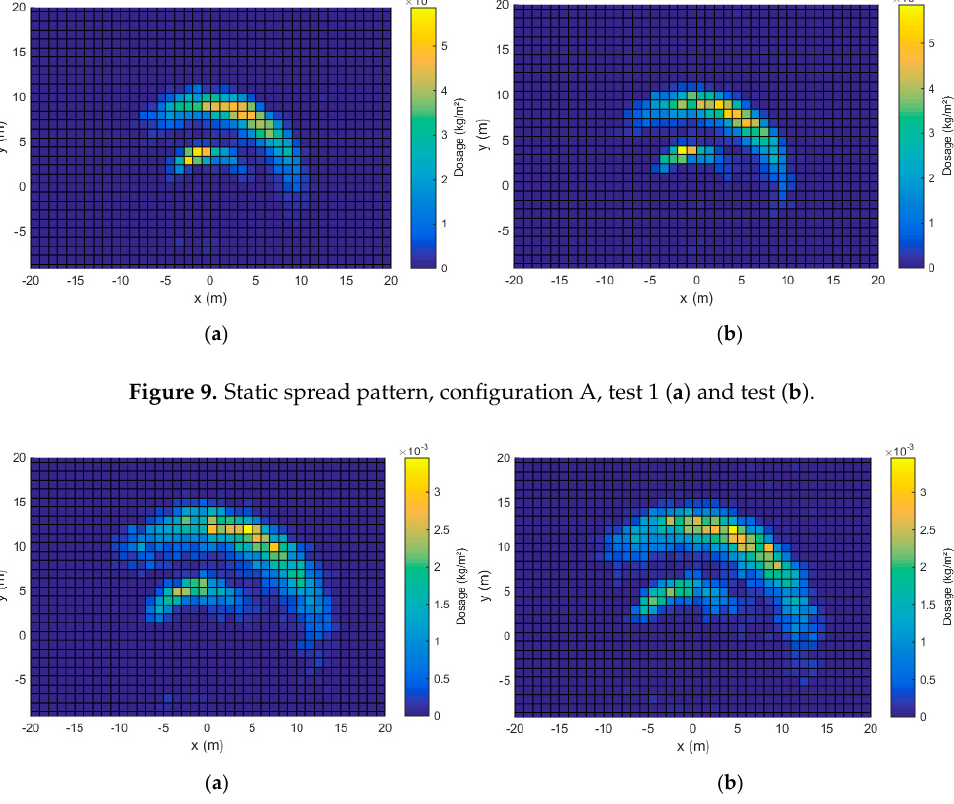
Figure 8. Histograms of resulting velocities for configuration A ( a ) and B ( b ). The overlap is given in brown.